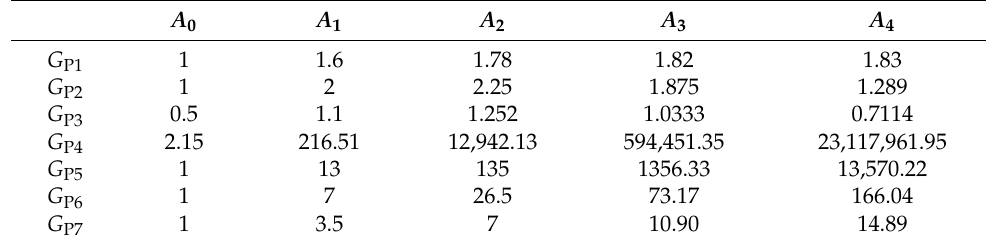
Figure 6. The absolute difference of the IAE criteria for process G P1 (s) parameters perturbation. Values are calculated from the IAE criterion of the method proposed by Vreˇcko et al. [44] and the IAE criterion of the proposed model identifica- tion method. Table 1. The calculated characteristic areas from the time responses of the process models.